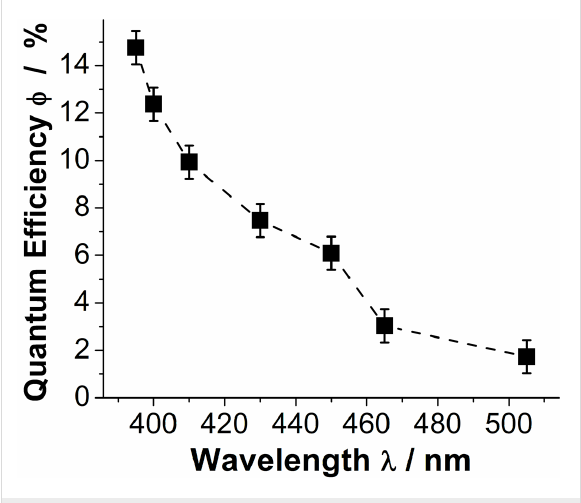
Figure 4: Quantum effiencies Φ for the homogeneous photooxidation of indigo by 1 in the visible range between λ = 395–505 nm. Solvent: DMF (aerobic), molar ratio [Ind] 0 :[1] = 1:1. light source: monochro- matic high-power LED, quantum efficiencies were determined using